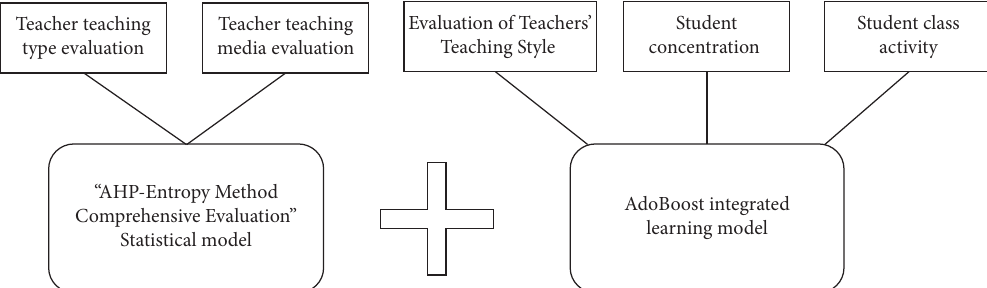
Figure 7: Comprehensive evaluation model.